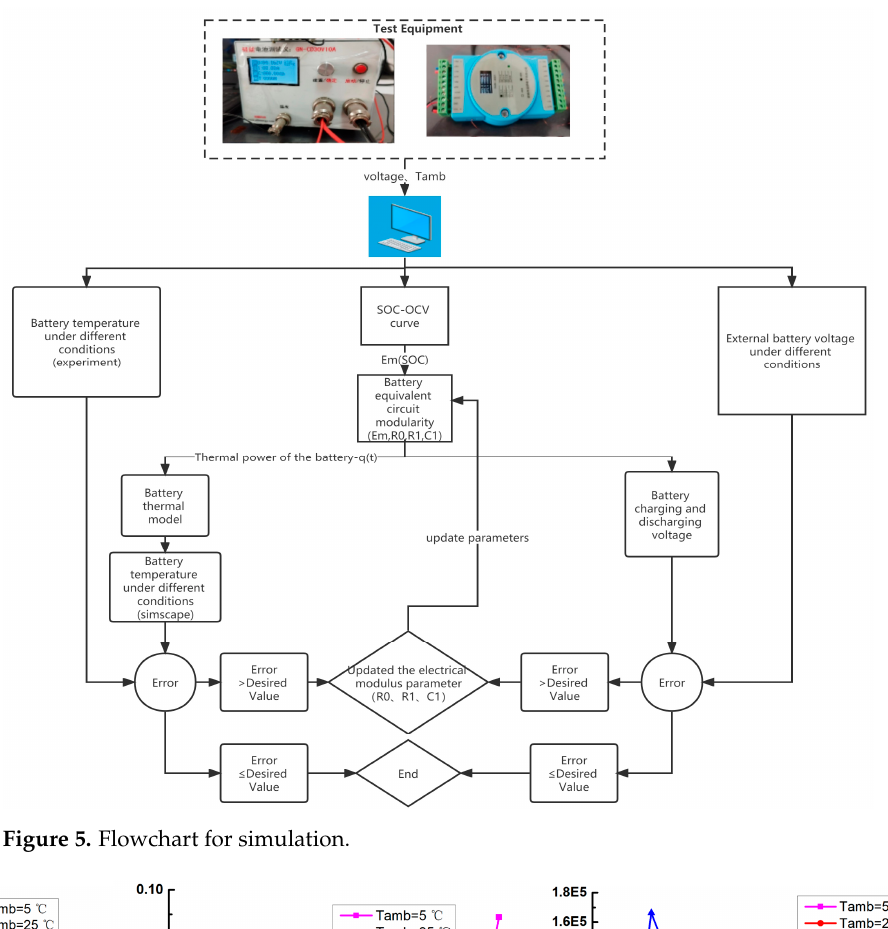
Figure 5. Flowchart for simulation.